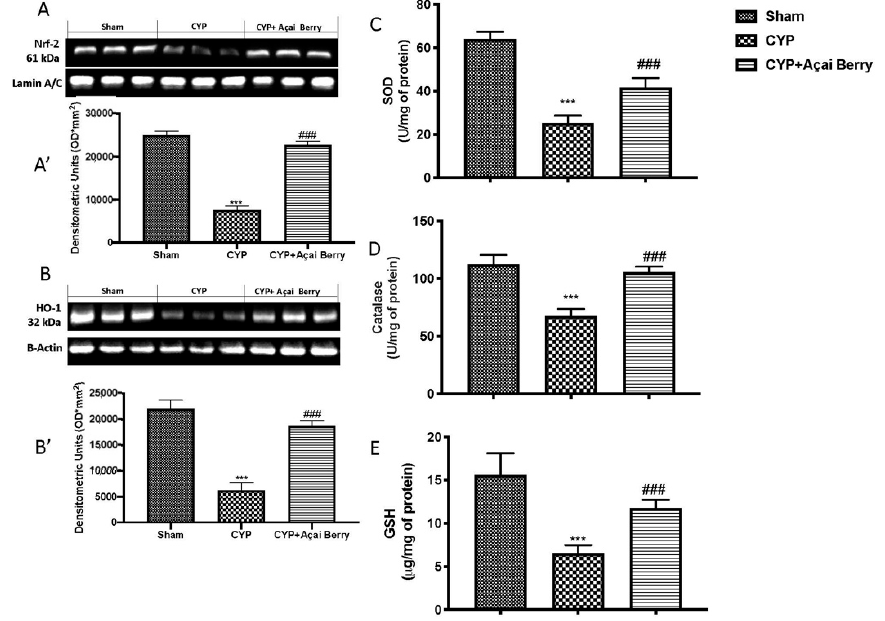
Figure 7. Açai berry administration improves endogenous oxidative defense. ( A ) Western blot of testicular tissue for Nrf2 and ( A’ ) densitometric analysis; ( B ) Western blot of HO-1 and ( B’ ) densi- tometric analysis. Analysis of ( C ) SOD, ( D ) catalase, and ( E ) GSH in testis. *** p < 0.001 vs. sham; ### p < 0.001 vs. CYP.